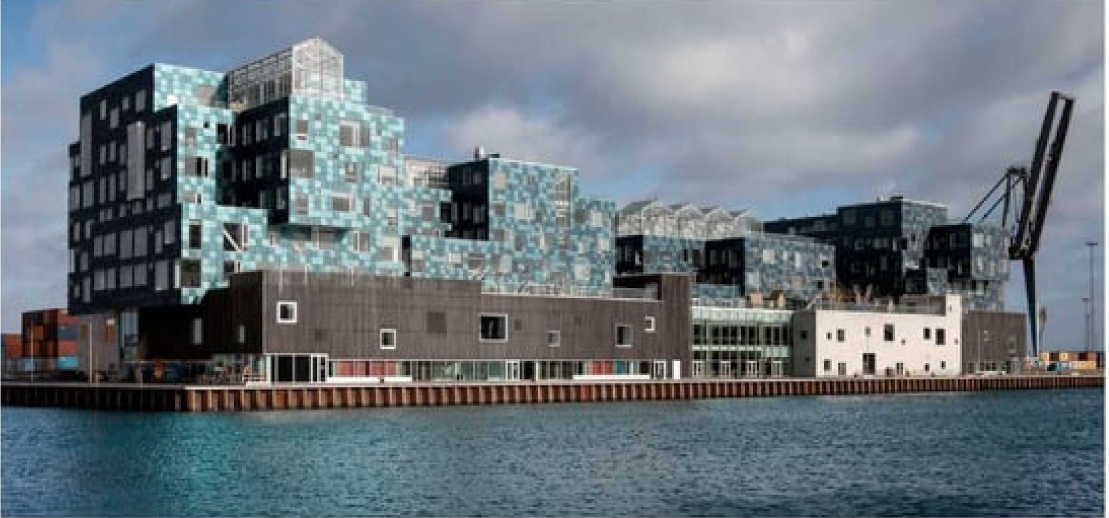
Figure 1. Sea view shot by Adam Moerk of the Copenhagen International School, Denmark